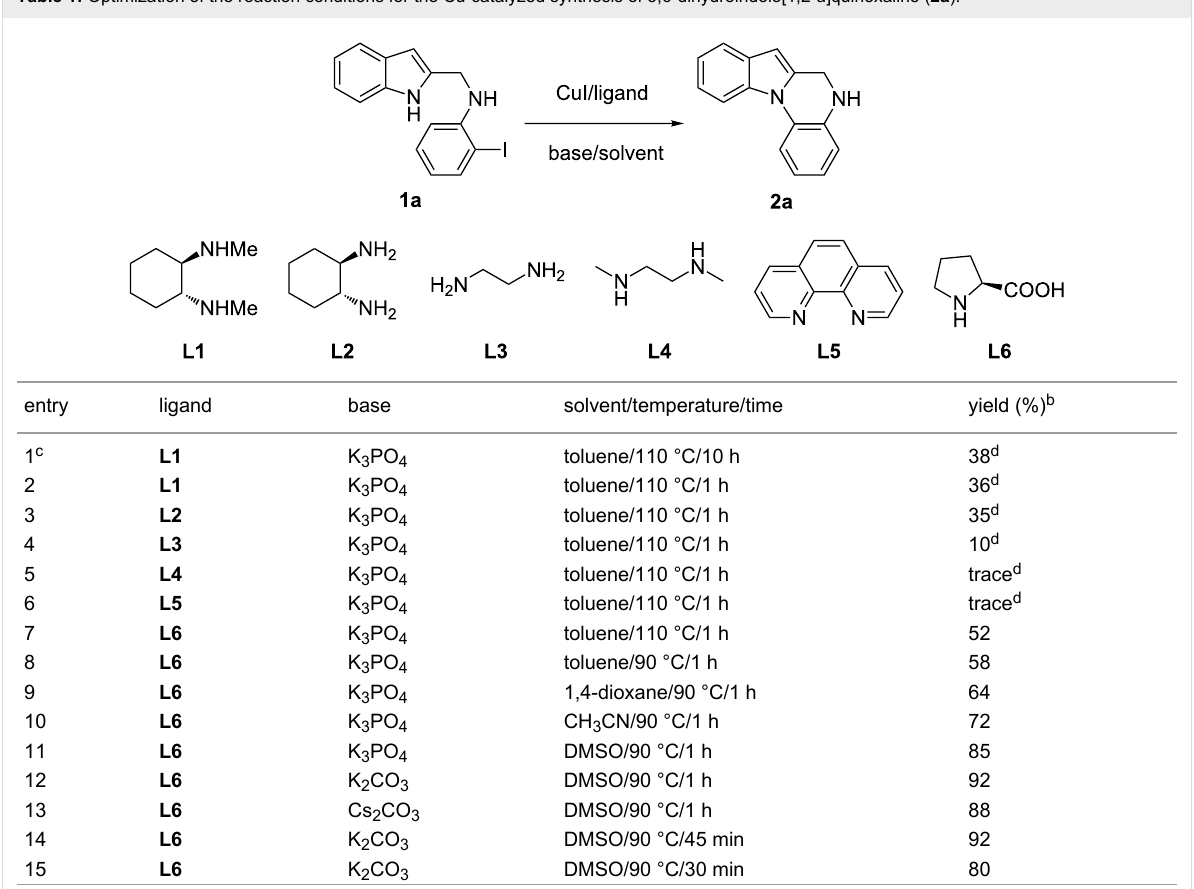
Table 1: Optimization of the reaction conditions for the Cu-catalyzed synthesis of 5,6-dihydroindolo[1,2- a ]quinoxaline ( 2a ).